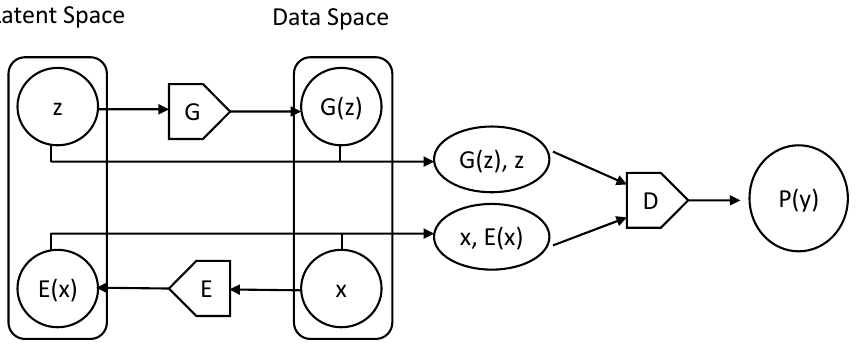
Figure 1. The structure of bidirectional generative adversarial